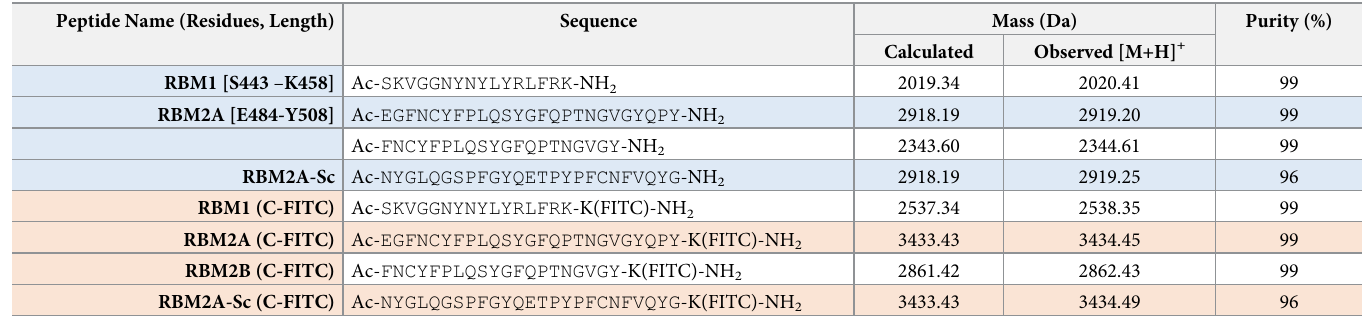
See S2 – S9 Figs for HPLC traces. RBM, receptor binding motif; Sc,